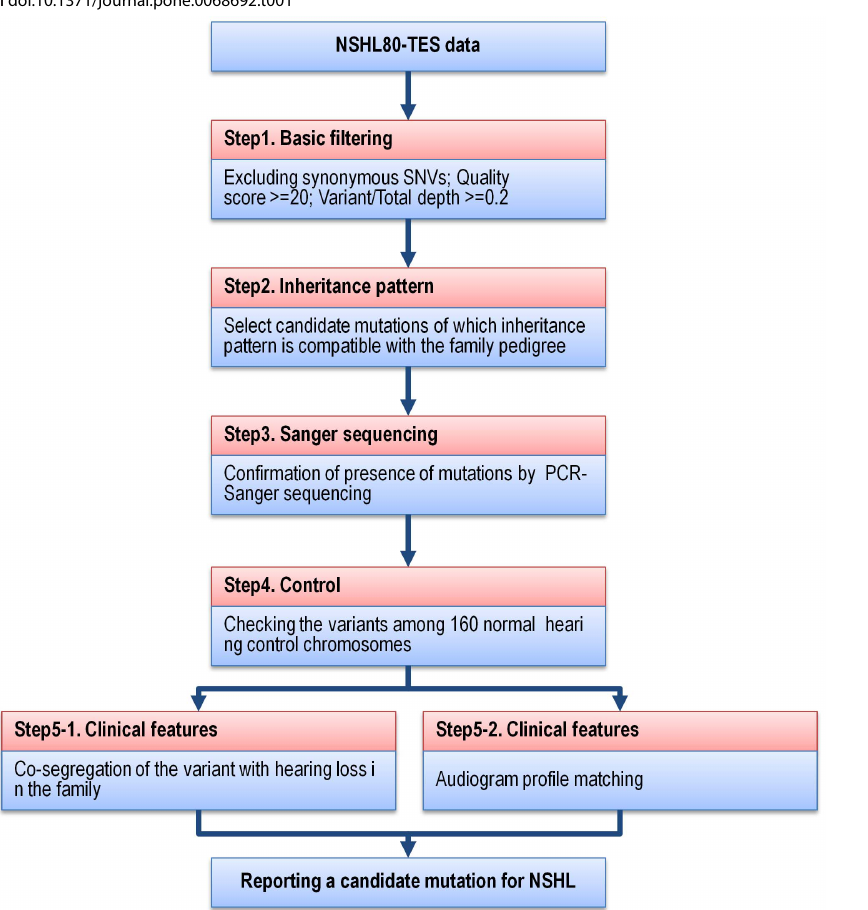
Figure 1. Analysis flow of NSHL-80 targeted resequencing on familial NSHL. Targeted resequencing data from 20 familial NSHL cases were filtered through five steps to select candidate SNVs in NSHL genes.